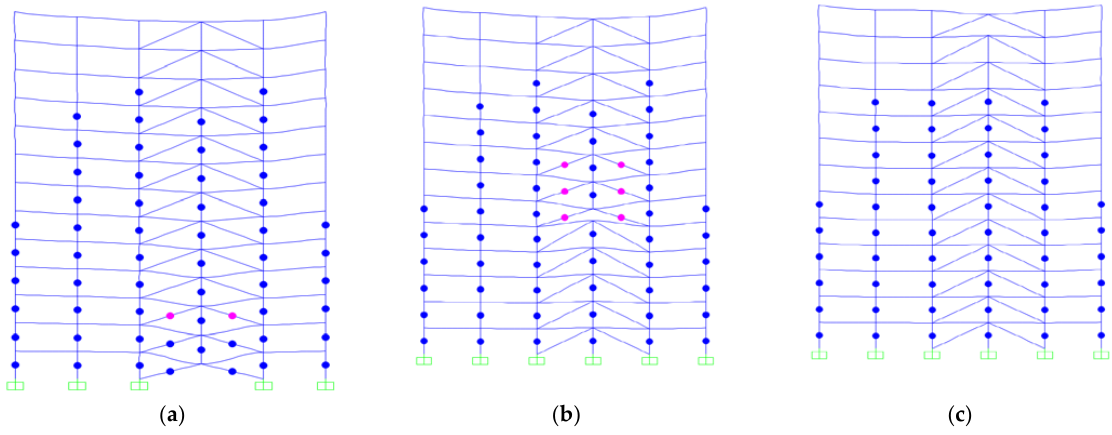
Figure 9. Hinge formation in the diagonally braced frame exposed to column removal in ( a ) story one, ( b ) story six, and ( c ) story thirteen.